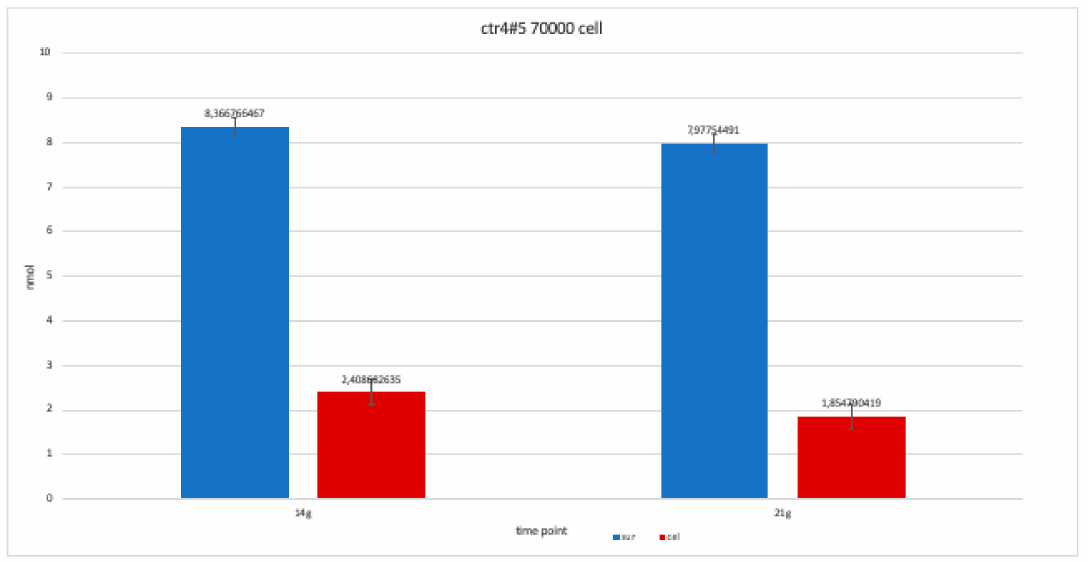
Figure 13. For clone CTR2#6 P19, we only performed two alkaline phosphatases test at 14 and 21 days, since the availability of the number of cells was limited. The trend is increasing but still balanced.